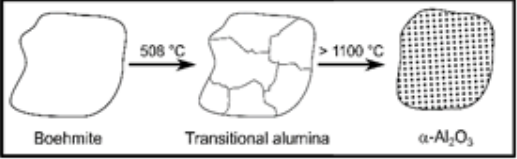
Table 1. Enthalpy of formation ( ΔH f ) and enthalpy of transition to α -Al 2 O 3 ( ΔH  α ), for different cubic alumina modification, as compiled from [2,3].